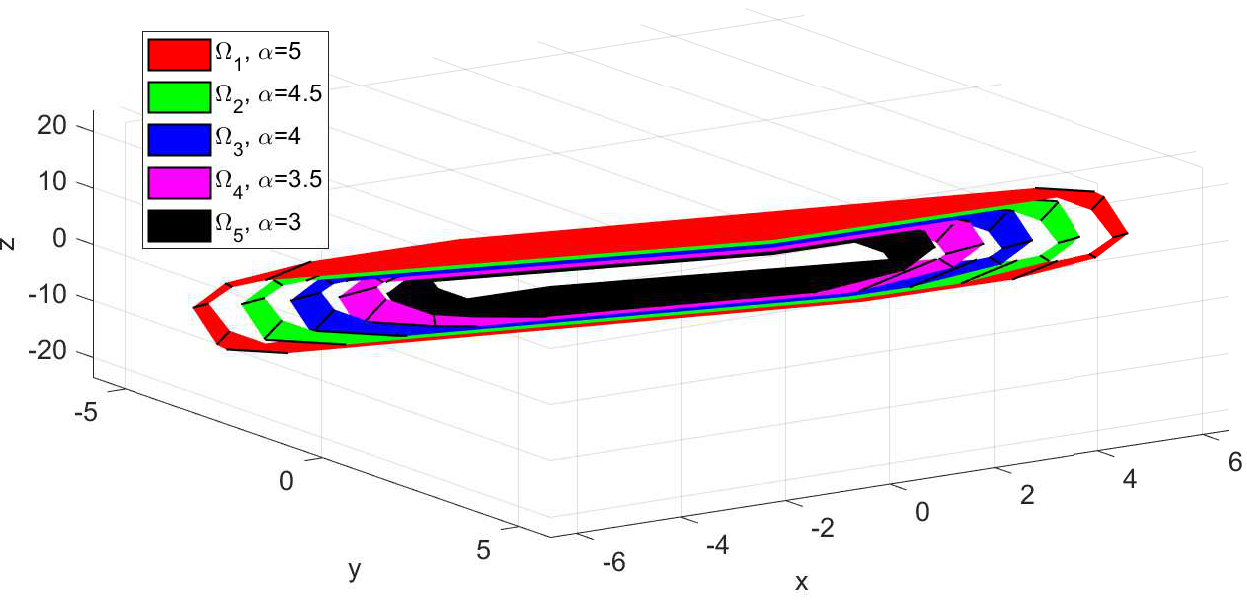
Figure 3. Detail regarding the depiction of the predefined invariant sets corresponding to sub-system S 1, computed for uncertainty constraint limit value β =